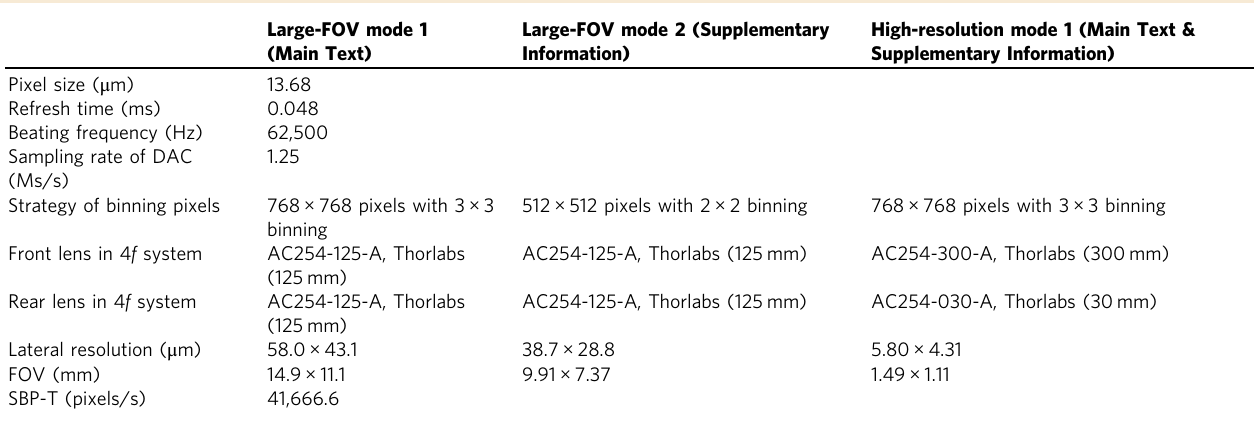
Table. 2 List of the parameters in both the large-FOV mode and the high-resolution